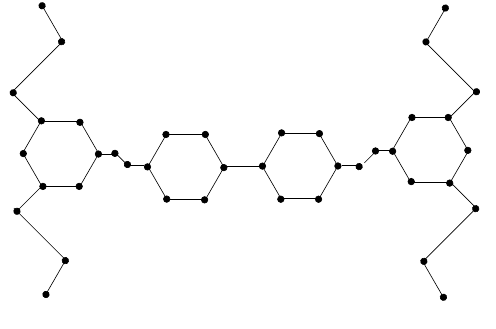
Figure 2. The graph of polyaryl ether dendrimer nanostar G 1 ( 0